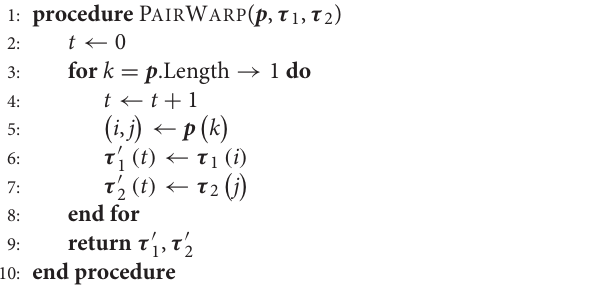
Algorithm 2 Warping for a Pair of Trajectories